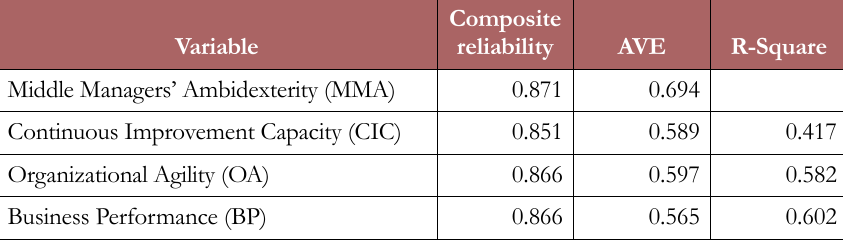
Table 3. Construct reliability